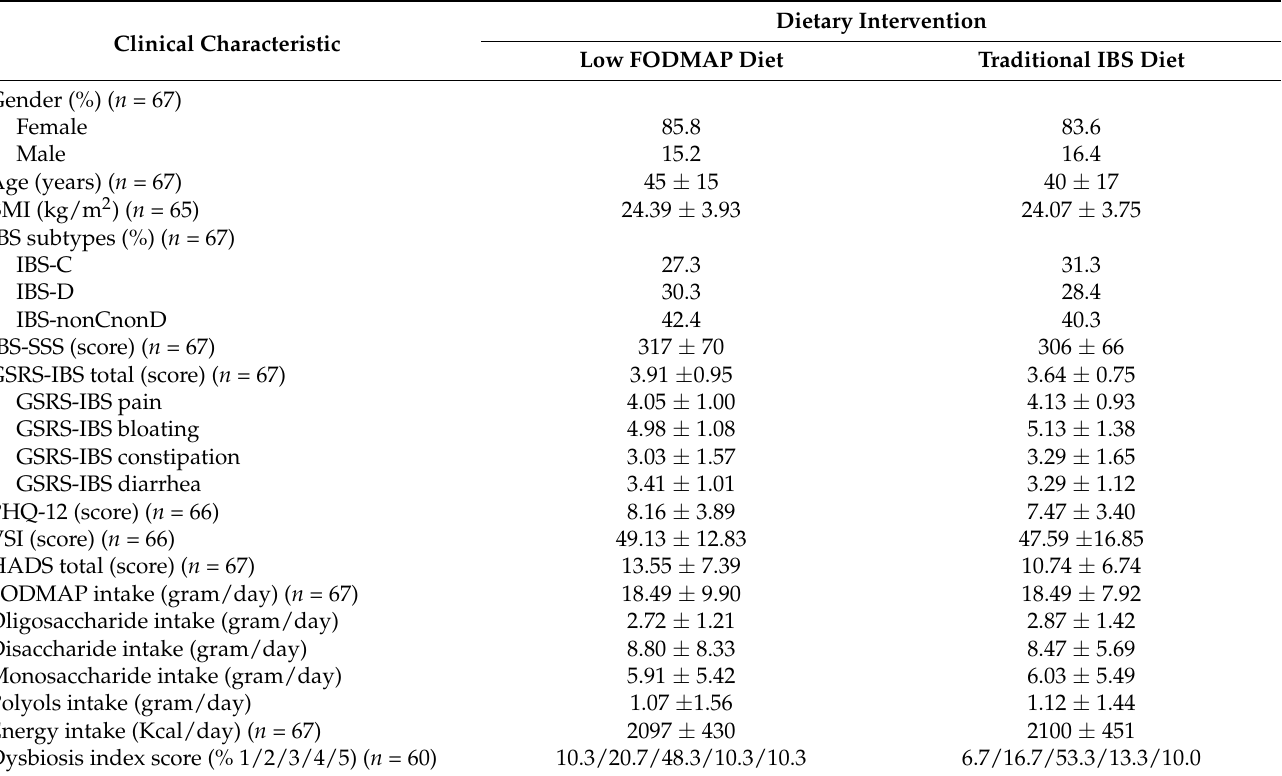
Table 1. Clinical characteristics of the two treatment arms at baseline